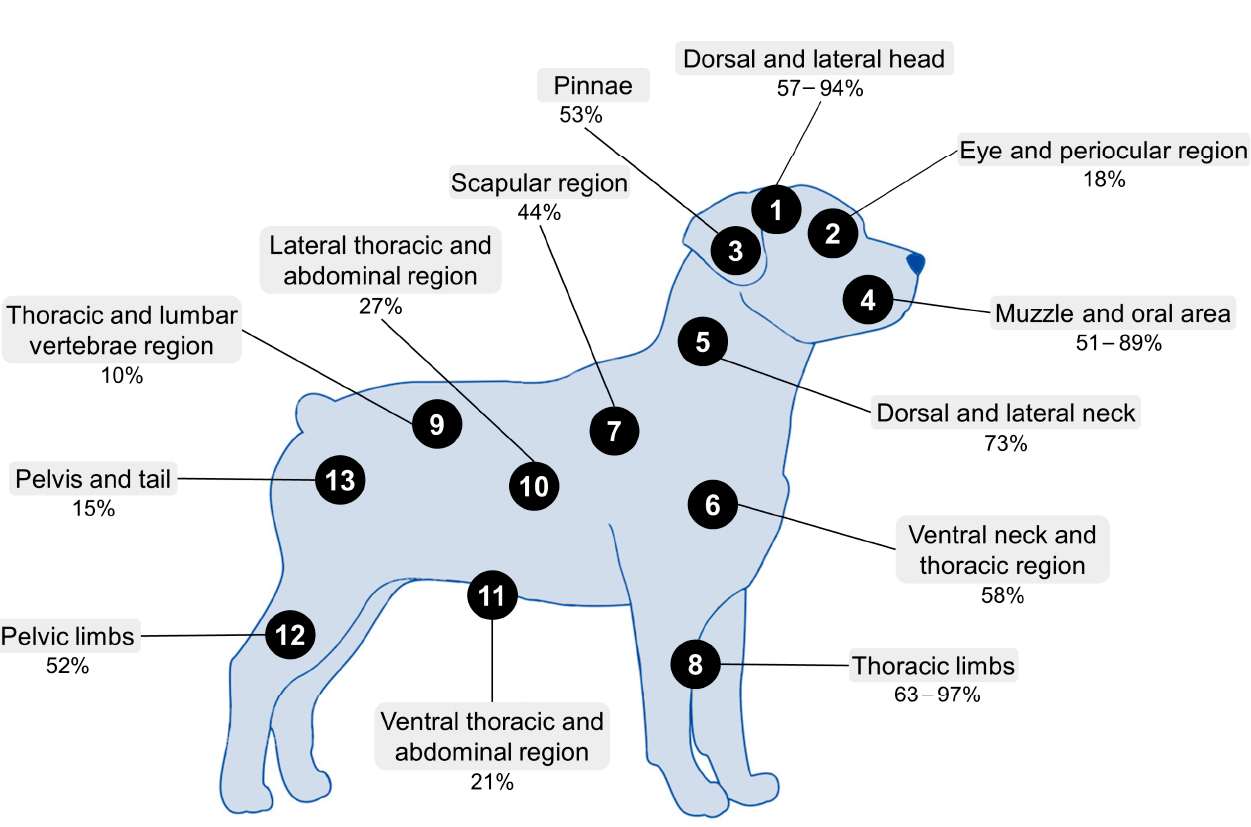
Figure 4. Corporal regions and percentage of the incidences of the principal lesions that occur during dogfights. 1. Dorsal and lateral area of the head with an incidence of 57–94%. 2. Ocular and periorbital region with an incidence of 18%. 3. Pinnae, incidence = 55%. 4. Muzzle and oral mucosa, incidence = 51–89%. 5. Dorsal and lateral aspects of the neck, incidence = 73%. 6. Ventral neck and thoracic region, incidence = 58%. 7. Scapular region, incidence = 44%. 8. Thoracic limbs, incidence = 63–97%. 9. Thoracic and lumbar vertebral region, incidence = 10%. 10. Lateral thoracic and abdominal region, incidence = 27%. 11. Ventral thoracic and abdominal region, incidence = 21%. 12. Pelvic limbs, incidence = 52%. 13. Pelvis and tail, incidence = 15% (Miller et al. [15] and Intarapanich et al. [5]).